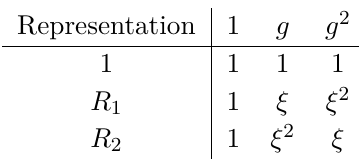
Table 1 . Character table for Z 3